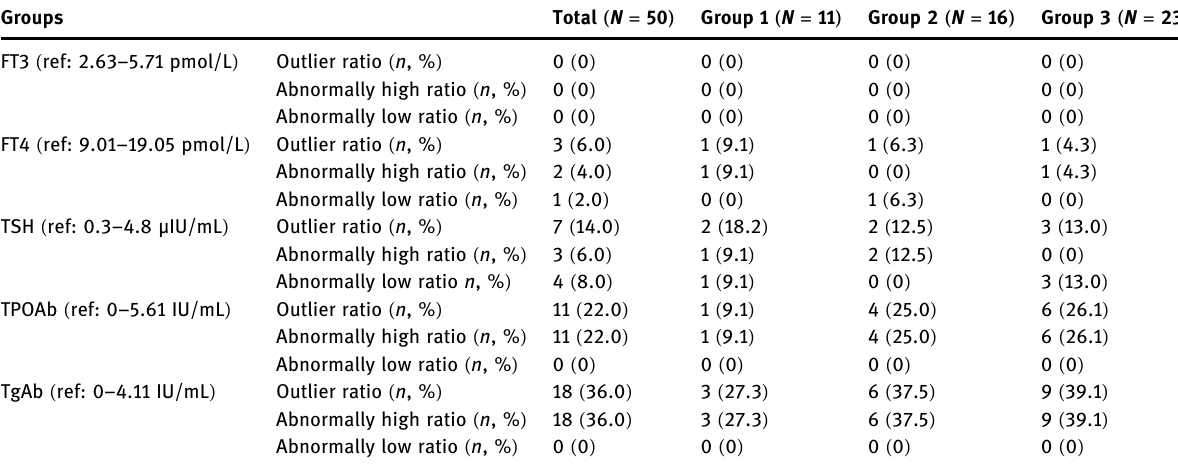
Table 5: Outlier comparison of thyroid function indicators Groups